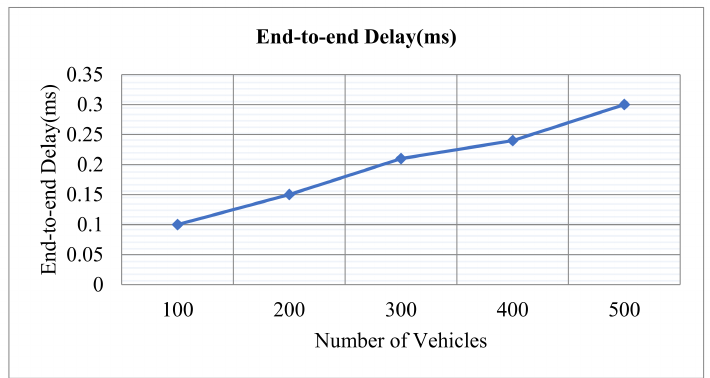
Figure 17. E2E Delay for increase in vehicle